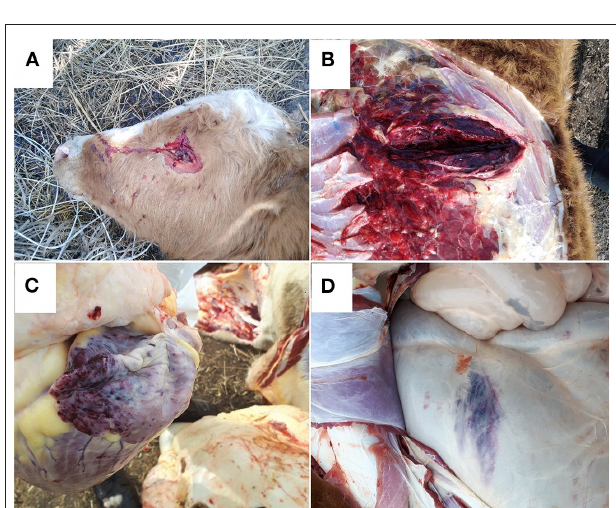
FIGURE 2 | Distinct clinical signs of blackleg: (A) oedema in the scapular shoulder joint of the anterior right limb; (B) oedema in the abdominal cavity; (C) oedema in the back; (D) papilloma trauma on the cow muzzle with subsequent oedema and the formation of nodes in the subcutaneous tissue in the area of the right branch of the jaw.